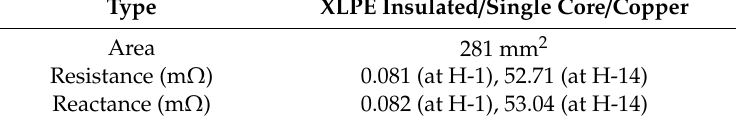
Table 1. Service cable parameters.